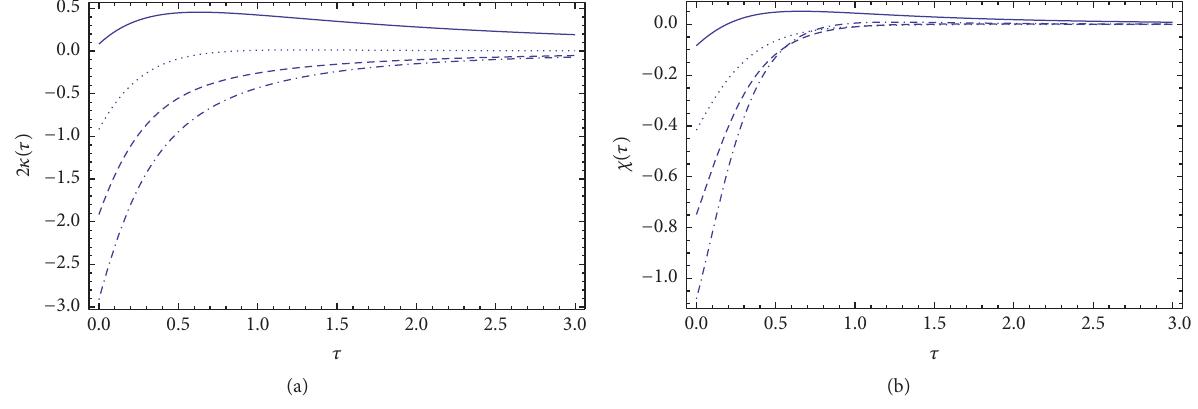
Figure 4: Time variations of the KCC invariants 2𝜅 = 𝑃 1 1 + 𝑃 2 2 (a) and 𝜒 = 𝑃 1 1 𝑃 2 2 − 𝑃 1 2 𝑃 1 2 (b) for a Universe filled with a scalar field with exponential potential, for different values of the parameter 𝜆 : 𝜆 = −1 (solid curve), 𝜆 = −√2 (dotted curve), 𝜆 = −√3 (dashed curve), and 𝜆 = −2 (dashed dotted